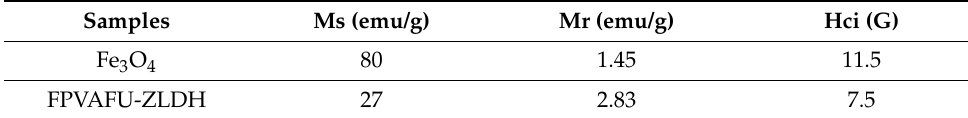
Table 2. Magnetic behavior of the synthesized